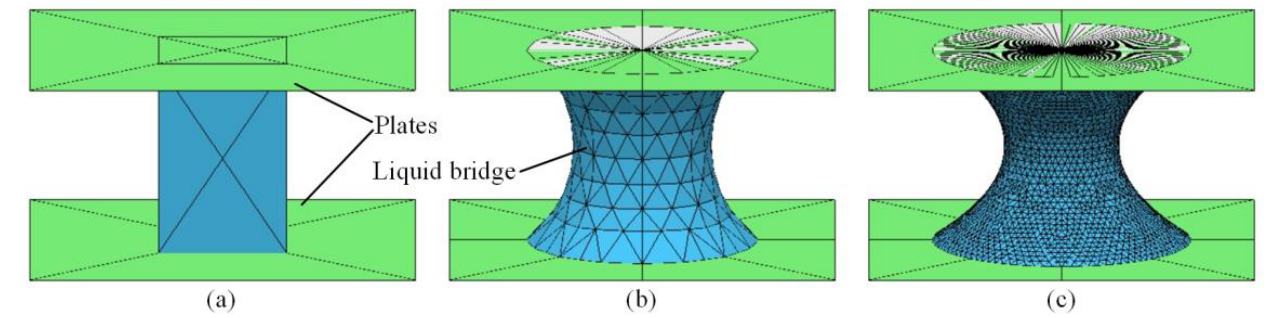
Figure 8. Surface evolution of the liquid bridge system: ( a ) initial definition, ( b ) deformation of evolution and ( c ) finished evolution with a stable liquid bridge.